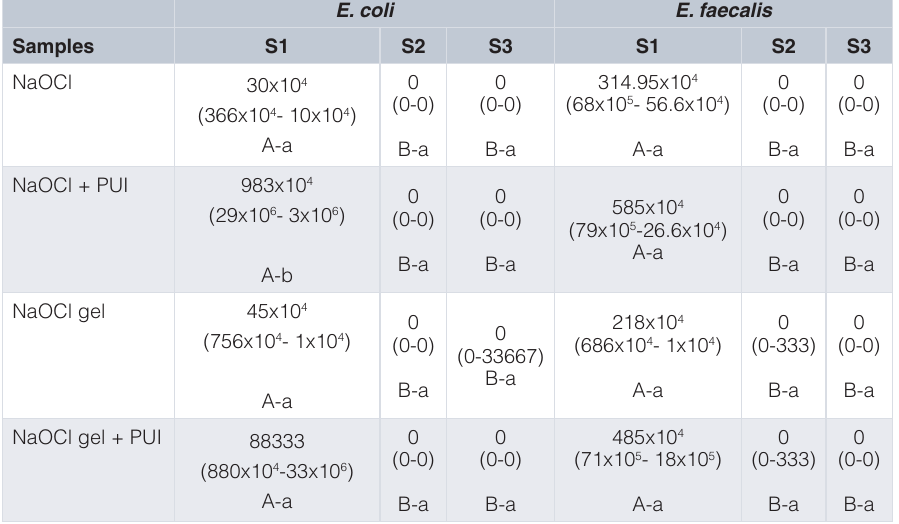
Table 2. Median of colony forming units/mL for E. coli and E. faecalis in all samples (S1, S2 and S3). NaOCL, sodium hypochlorite; PUI, passive ultrasonic irrigation. E. coli